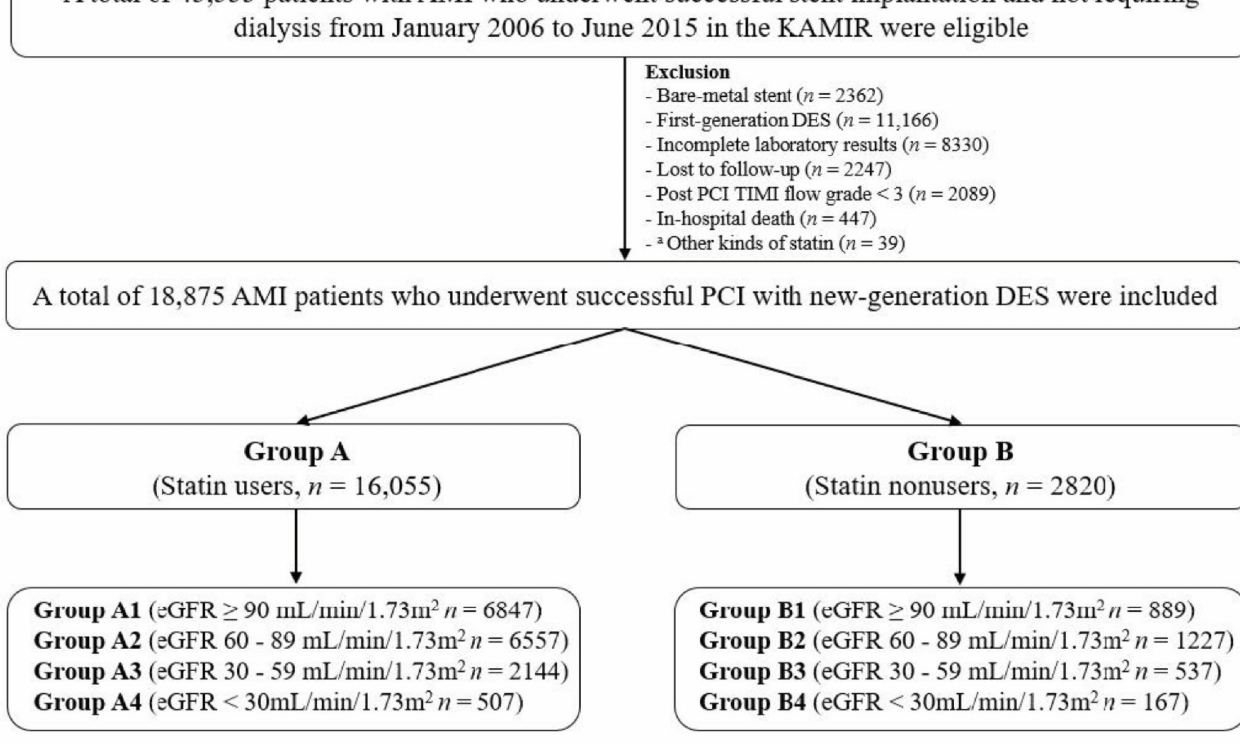
Figure 1. Flowchart. AMI, acute myocardial infarction; KAMIR, Korea AMI Registry; PCI, percutaneous coronary inter- vention; DES, drug-eluting stent; eGFR, estimated glomerular filtration rate. a Statins except for atorvastatin, rosuvastatin, simvastatin, pitavastatin, pravastatin and